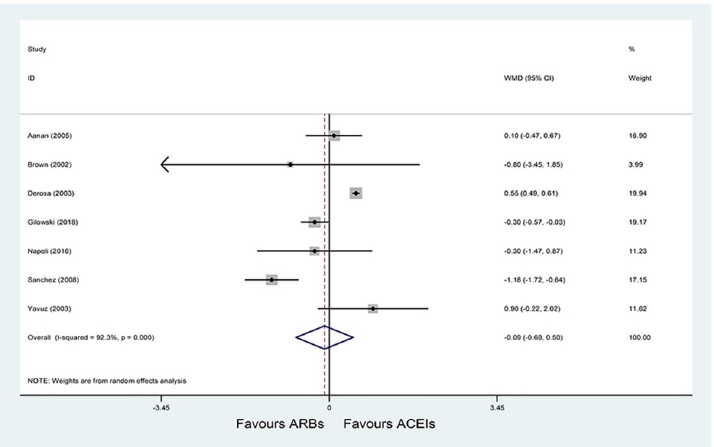
Fig 2. Effect of ARBs versus ACE inhibitors on